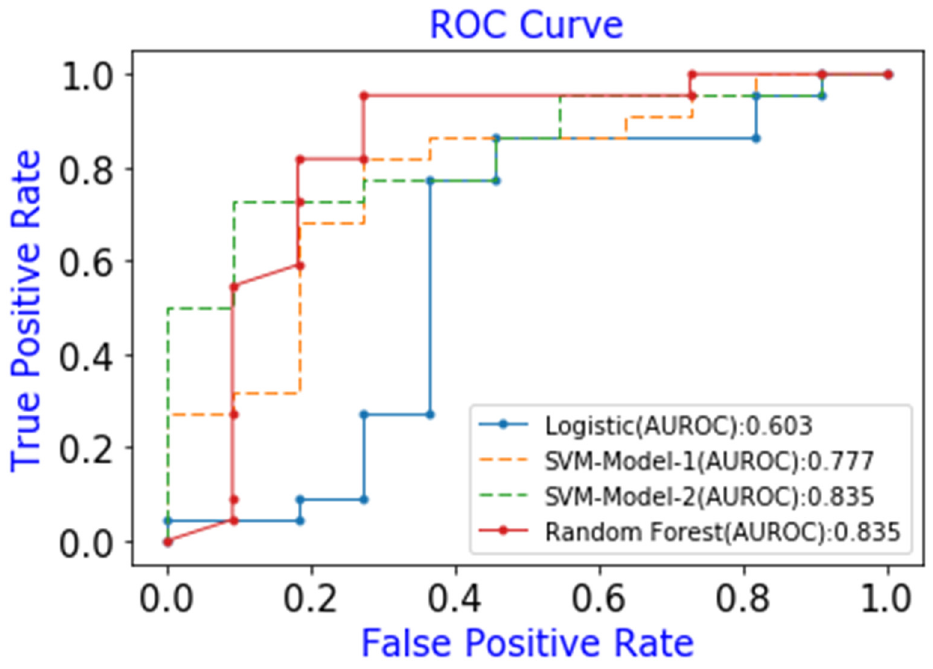
Figure 7. ROC curves for Logistic Regression, SVM and Random Forest models. In addition to the classification models, we applied regression analysis for the Mg- alloy dataset using the multivariate polynomial regression, because we have two varying independent variables. We chose YS and UTS as the independent variables to predict the values of dependent variable EL. The independent variables were transformed using the polynomial function of degree = 3 and the transformed values of YS and UTS, and original EL values are then split into the into test and train datasets. Out of 161 rows, 80% of dataset forms train data (128 rows) and the remaining 20% of the dataset (33 rows) as